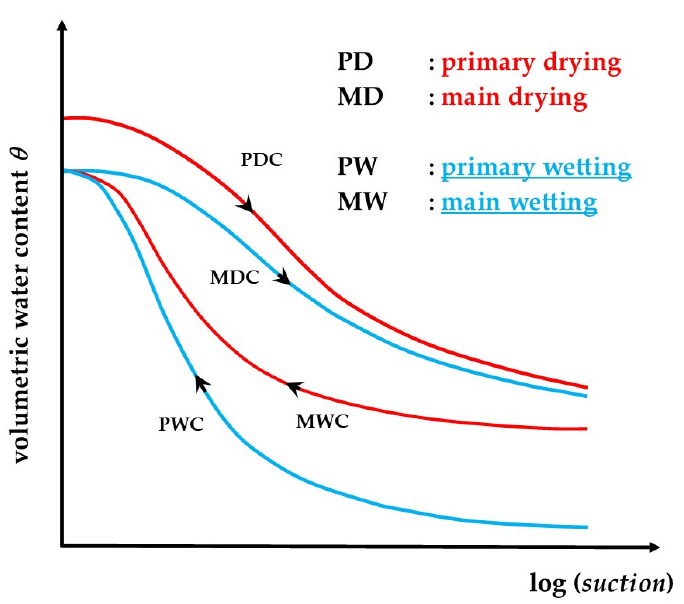
Figure 1. The framework of soil hydraulic histories (adapted from [7]).